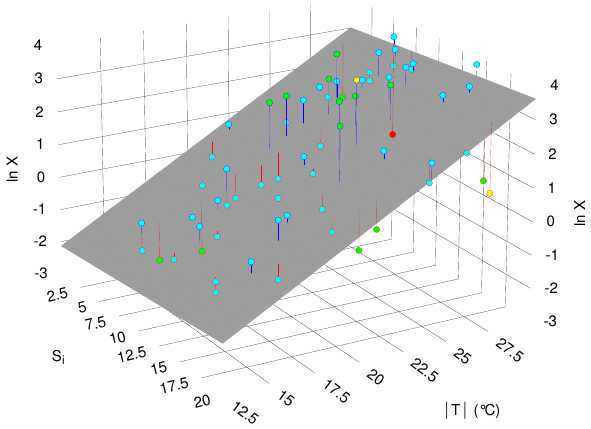
Fig. 8. Fitting of the IN concentration as a function of temperature and supersaturation given by Eq. (3), with the experimental data points superimposed. See text for